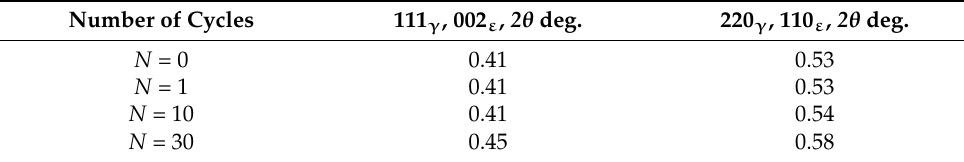
Table 2. Evolution of X-ray line half-height width during mechanocycling. Number of